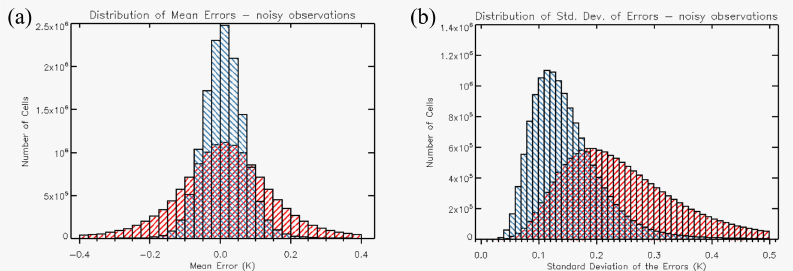
Figure 6. Statistics of the di ff erences between the analysis of January SST fields and the original “truth” SST for IR-only (red) and combined IR and MW (blue) input data with realistic errors: ( a ) mean error and ( b ) standard deviation of the error.